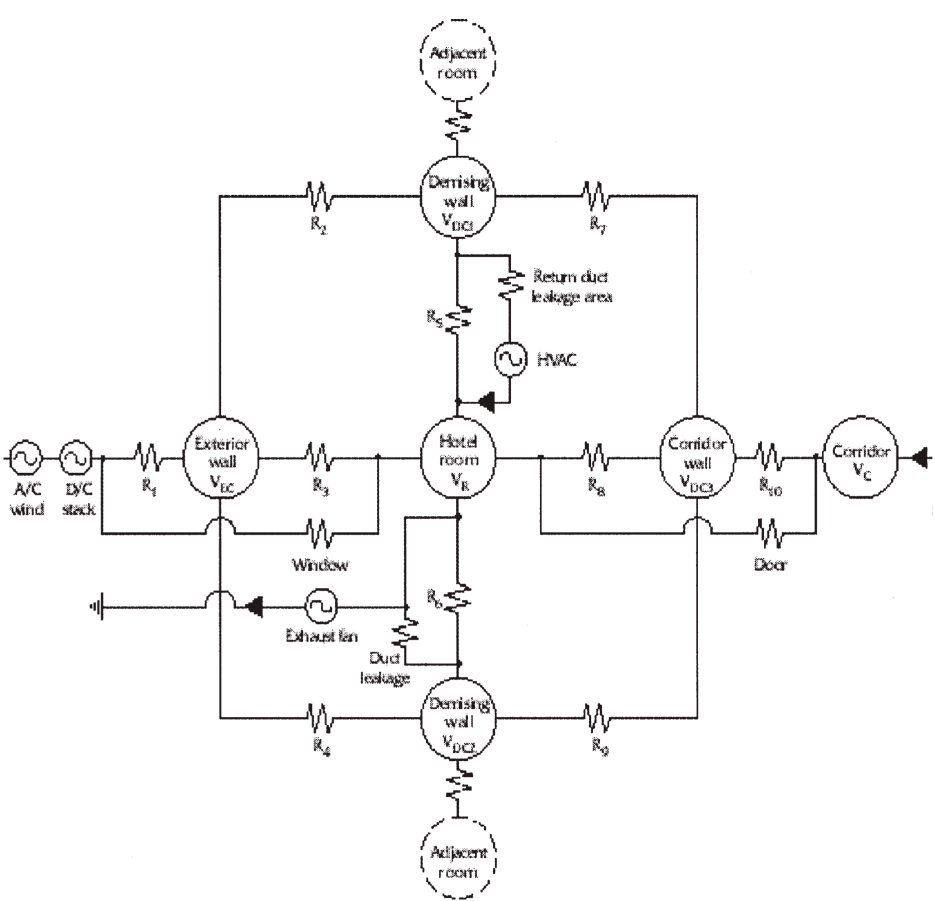
Figure 7. Lstiburek [50] defined various components of air flow on example of a hotel room using an electrical analogy. Reprinted with permission.